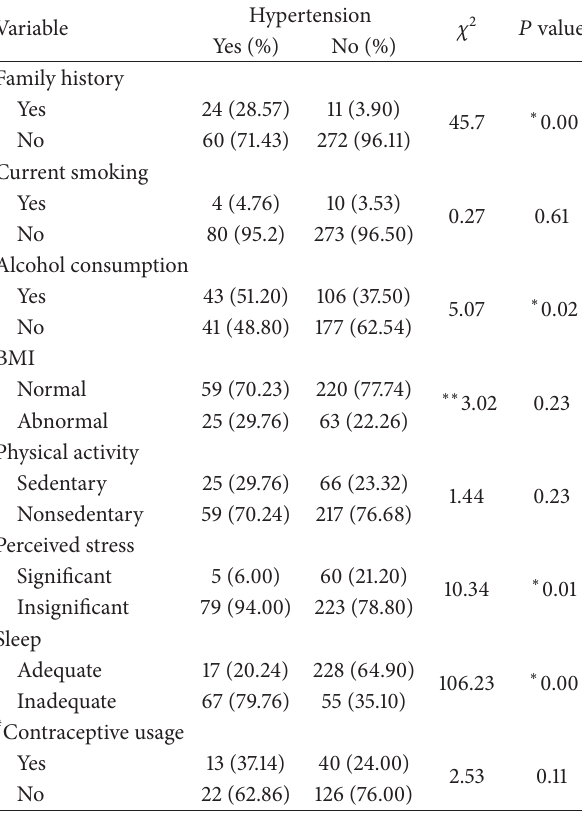
Table 2: Sociodemographic characteristics of subjects with and without hypertension.